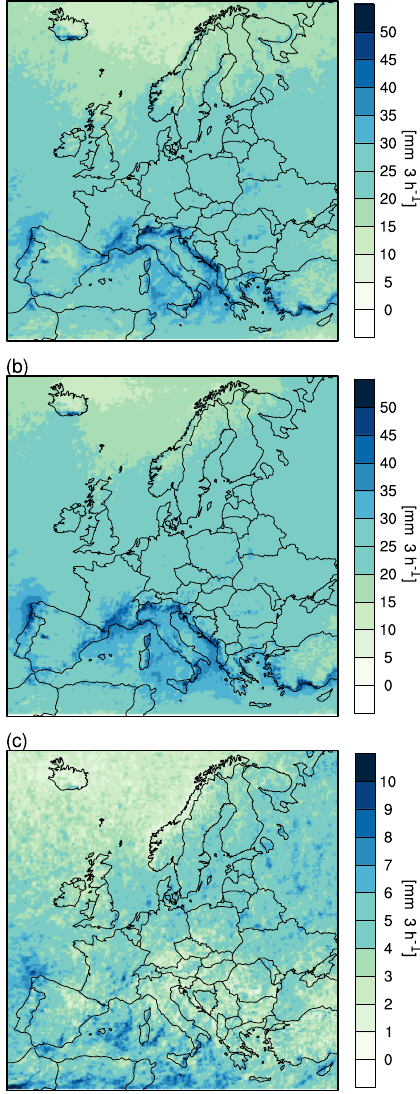
Figure 5. 10-year return level of 3-hourly precipitation. (a) ERA- Interim downscaled with RCA4 and RACMO22E for the period 1981–2010 (b) ensemble mean of EURO CORDEX simulations (c) ensemble